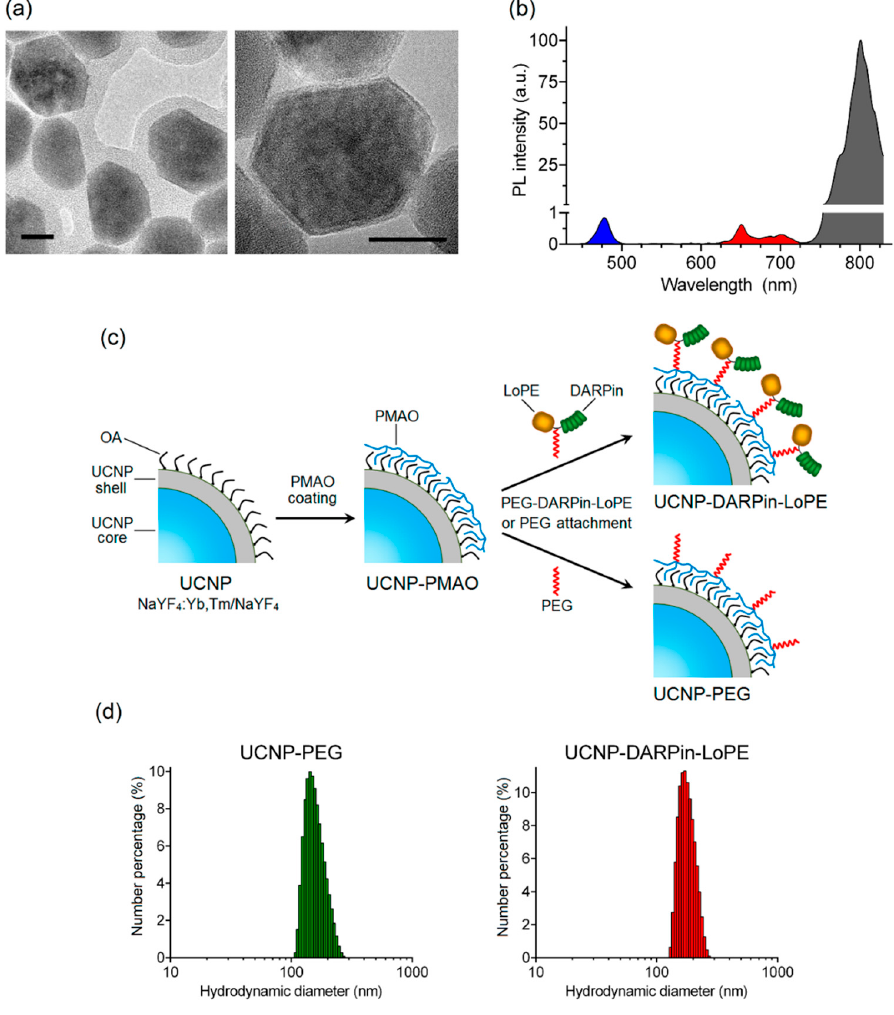
Figure 1. Preparation and characterization of theranostic nanocomplexes. TEM images of upconversion nanoparticles (UCNP) (NaYF 4 : Yb, Tm/NaYF 4 ). Scale bar 20 nm. ( a ). PL emission spectrum of UCNP under excitation at 980 nm ( b ). The preparation scheme of UCNP-DARPin-LoPE nanocomplexes and non-targeted UCNP-PEG ( c ). Hydrodynamic diameter distributions of UCNP- polyethylene glycol (UCNP-PEG) (left) and ( d ) UCNP-DARPin-LoPE (right) acquired by dynamic light scattering in aqueous solutions.